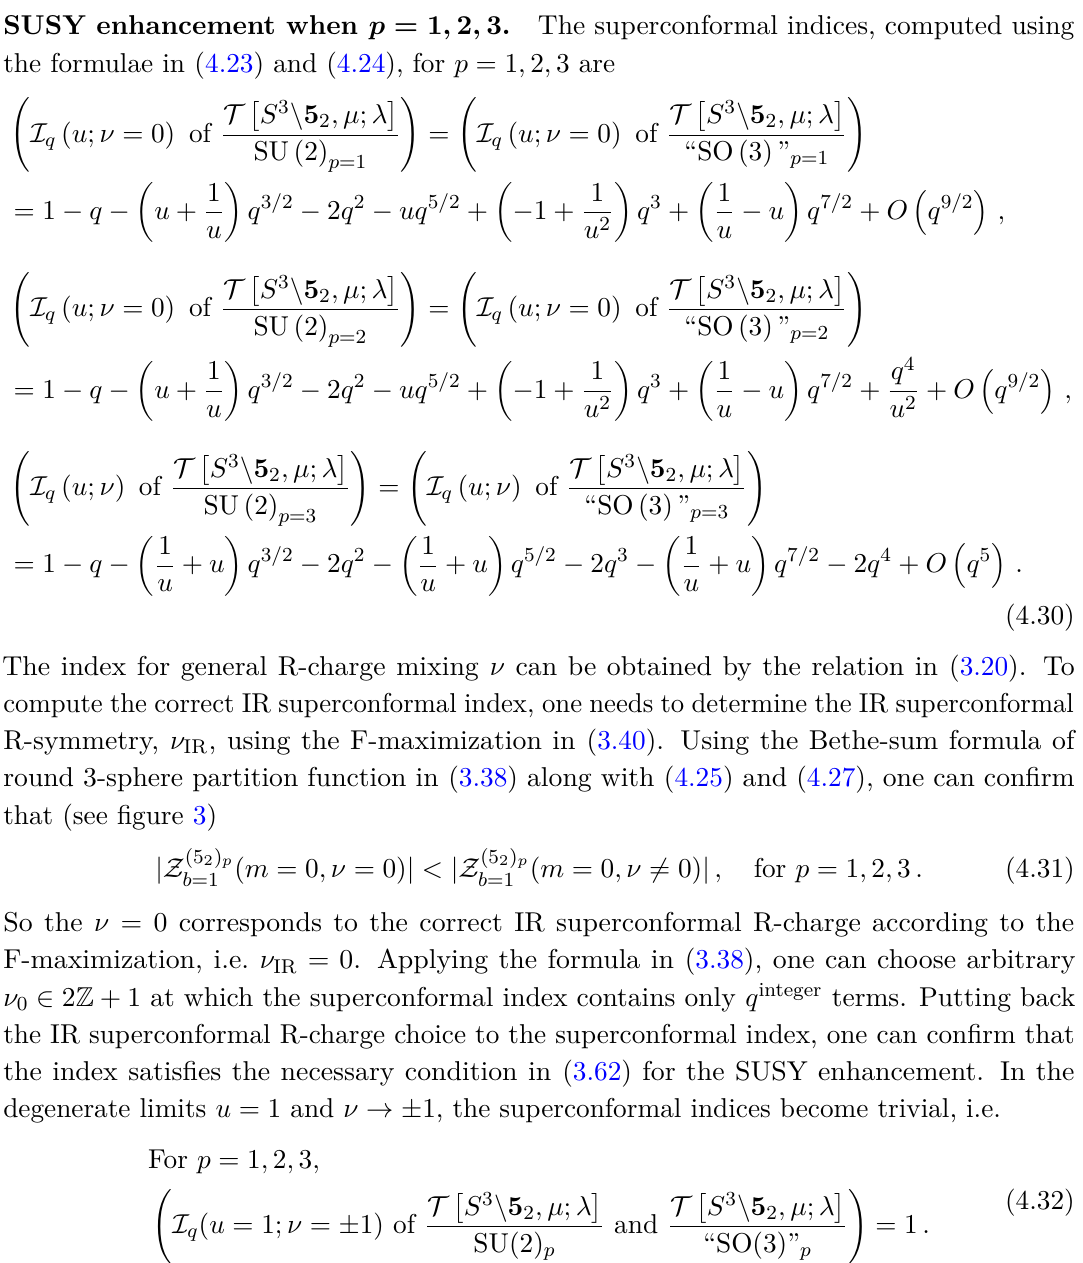
q q q sin( π ) , sin( π ) and sin( π ) for p = 1 , 2 , 3 respectively. 2 1 1 11 11 7 7 5 5